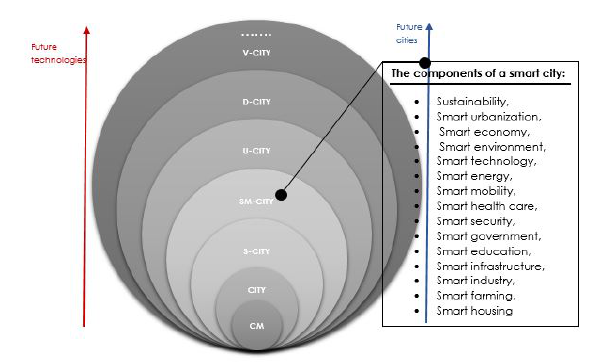
Figure 3. Ideological proposal towards future cities in line with